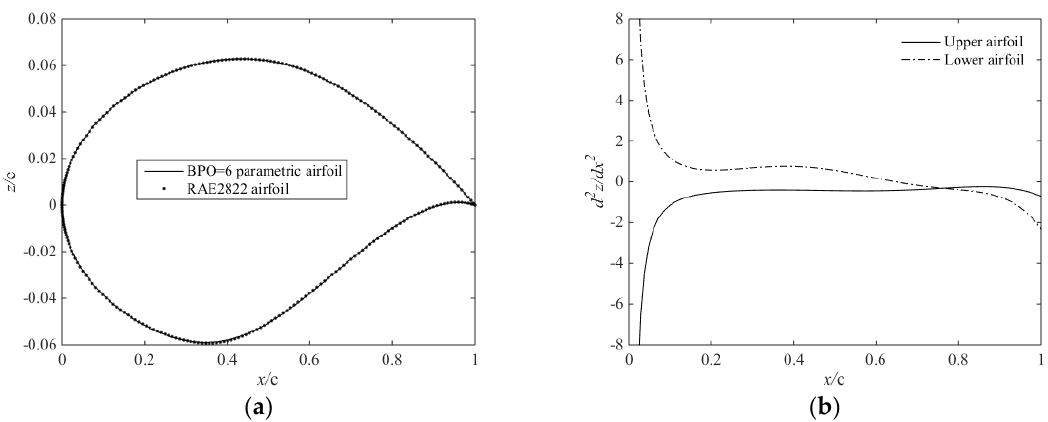
Figure 4. ( a ) Comparison between the CST parametric airfoil and the RAE2822 airfoil ( b ) RAE2822 airfoil second derivatives when BPO = 6.